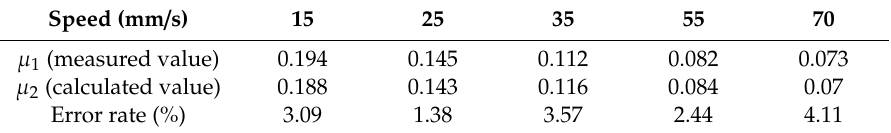
Table 3. Friction coe ffi cient measurement and function model prediction.